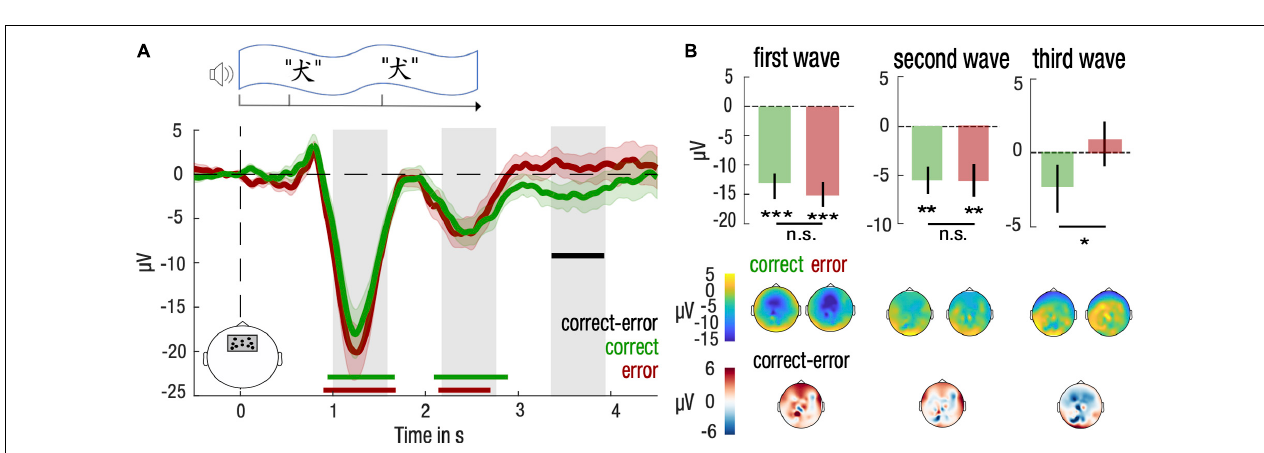
FIGURE 3 | Differential entrainment of frontal neural responses at a slow-wave frequency to stimulation for correctly and incorrectly identified items during NREM sleep. (A) Neural responses were computed over a frontal cluster of electrodes depicted in the lower left panel. Time-course of the stimulus presentation was indicated in a top panel. Time-courses of the brain responses (lower panel) were averaged across participants and smoothed for visualization purposes only, using a 500-ms wide Gaussian kernel. Mean and standard error of the mean (SEM) are represented, respectively, with solid lines and shaded areas for the correct (green) and the error (red) trials. Statistical tests were performed on brain responses before smoothing. Green, red and black horizontal lines denote significant clusters of neural responses differing from baseline (0, dotted line) across participants for, respectively, correct trials, error trials, or the difference between both conditions ( P < 0.05 after cluster correction). Gray bars indicate time clusters corresponding to negative half-periods of a slow wave rhythm at 0.85 Hz. (B) Neural responses were averaged over each negative half-period of slow waves and compared between correct (green) and error (red) trials. Mean and standard error of the mean (SEM) are represented, respectively, with bar plots and solid lines. Student’s T -test against baseline (0, dotted line) was computed for correct and error trials and corrected for multiple comparisons. Paired Student’s T -test were computed between correct and error trials (*** P < 0.001, ** P < 0.01, * P < 0.05). Topography of amplitudes were indicated in lower panels for correct, error and the difference between correct and error